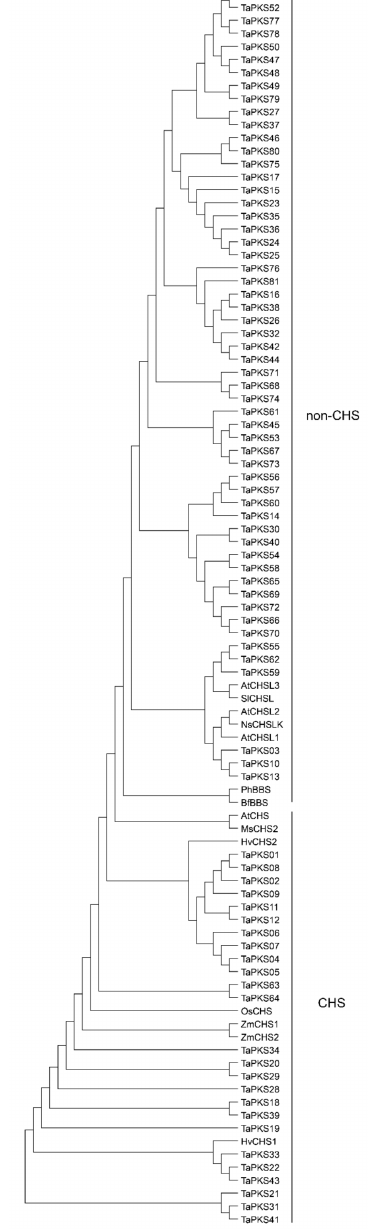
Figure 2. Evolutionary tree constructed based on PKS family genes in wheat and other species. The CHS superfamily includes CHS and a series of chalcone synthase-like (CHSL, also called non-CHS) genes [20,21]. Their functional differences are mainly reflected in the selection of initial substrates and the number of condensation reactions (polyketide chain extension length)